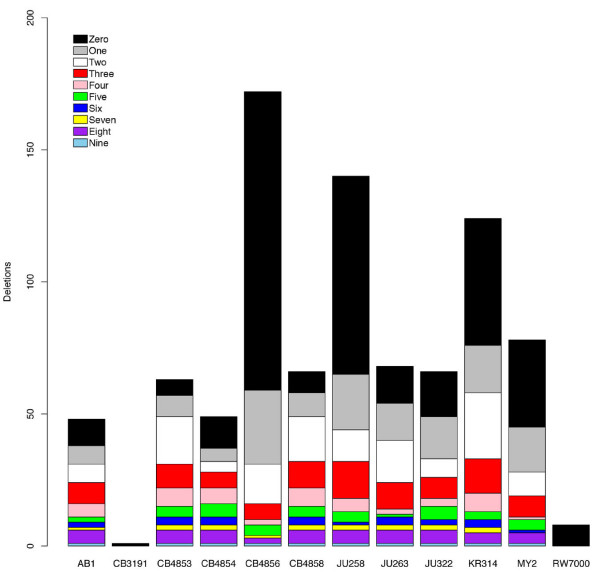
The number of deletions in each of 12 natural isolates of C. elegans that are also present in other isolates. The numbers of other isolates that carry the same deletions are indicated by the colors in the figure legend.